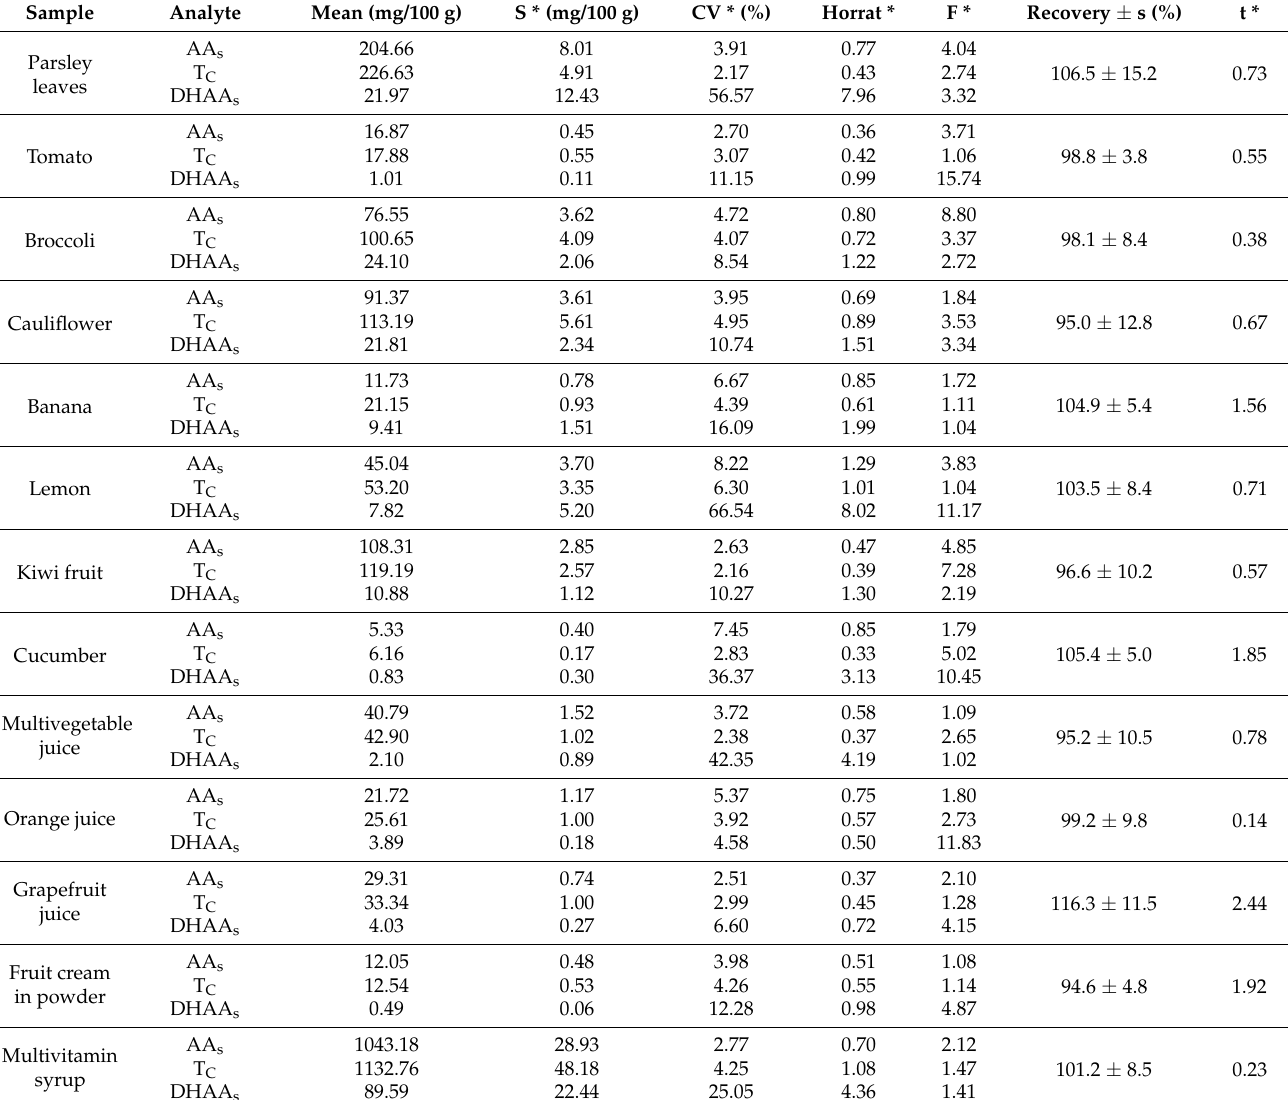
Table 2. Ascorbic acid, total vitamin C and dehydroascorbic acid content in the samples obtained by differential pulse voltammetry and statistical characteristics of the precision of determinations and recovery (t cr = 4.303 and F cr = 19 for α =